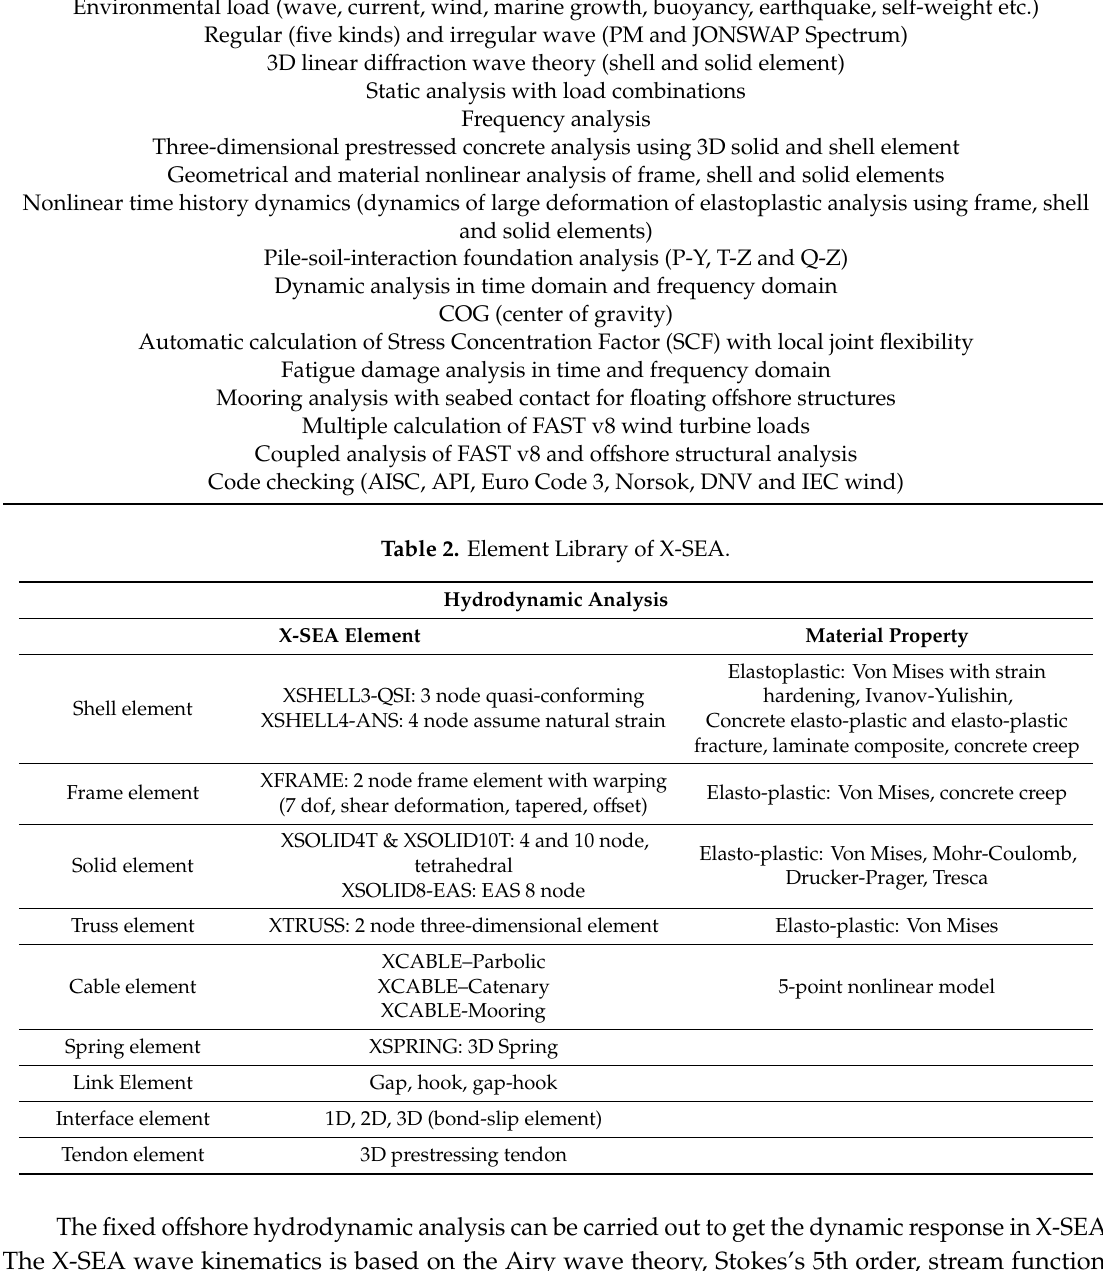
Table 1. O ff shore structural analysis options of X-SEA. Solution Features of X-SEA